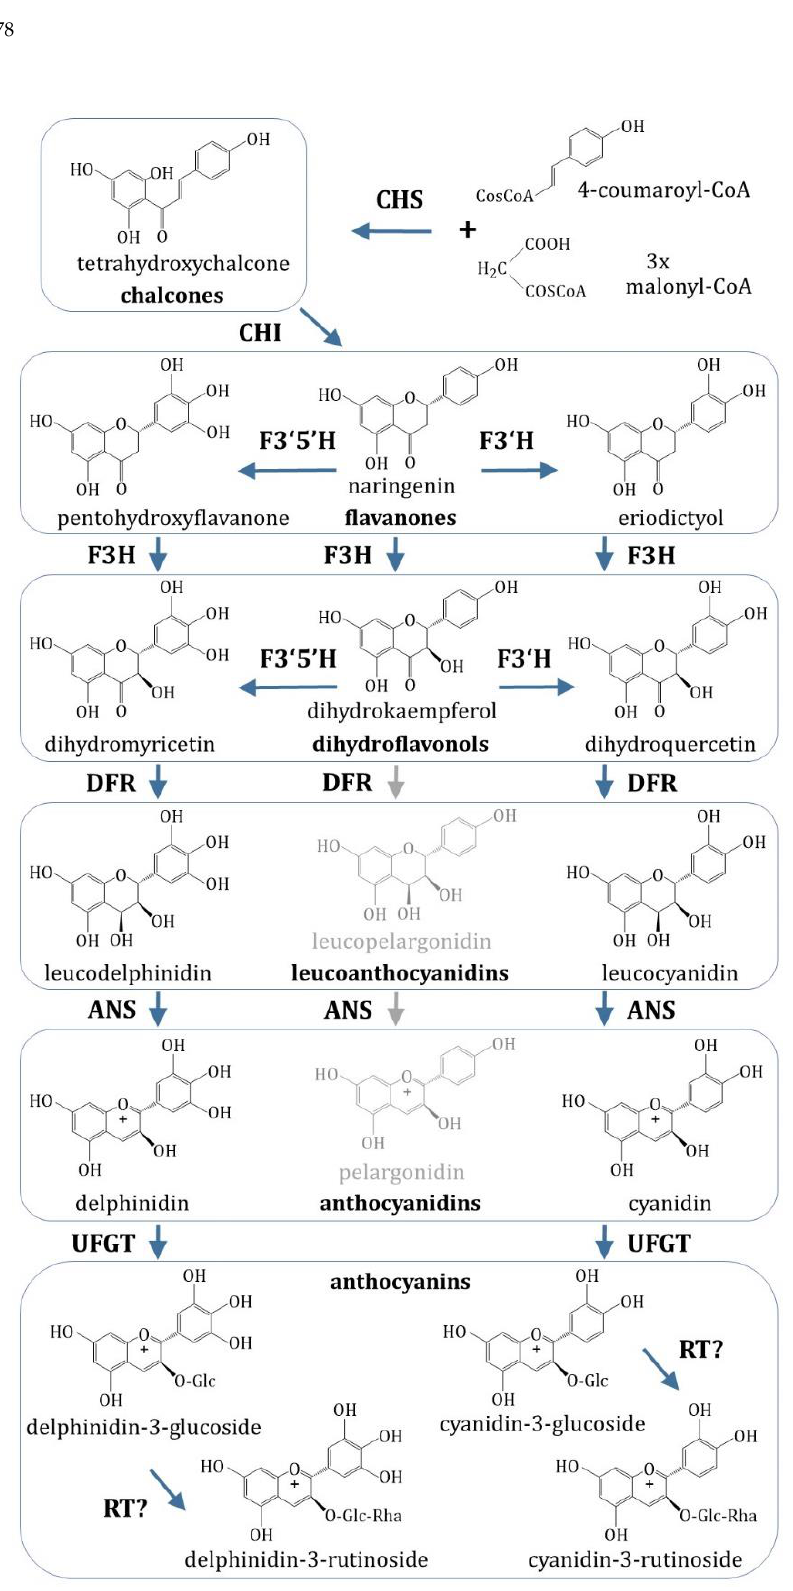
Figure 1. Putative anthocyanin pathway in fruits of the Ribes genus. Only the branches leading to the most prevalent Ribes anthocyanins, delphinidin-3-O-rutinoside and cyanidin-3-O-rutinoside, are completely shown. Abbreviations of enzymes: CHS, chalcone synthase; CHI, chalcone isomerase; F3H, flavonoid 3-hydroxylase; F3′H, flavonoid 3′ - hydroxylase; F3′5′H, flavonoid 3’,5’ -hydroxylase; DFR, dihydroflavonol reductase; ANS, anthocyanidin synthase; UFGT, UDP-glucose:flavonoid 3-O-glucosyl transferase; RT, putative rhamnosyltransferase.